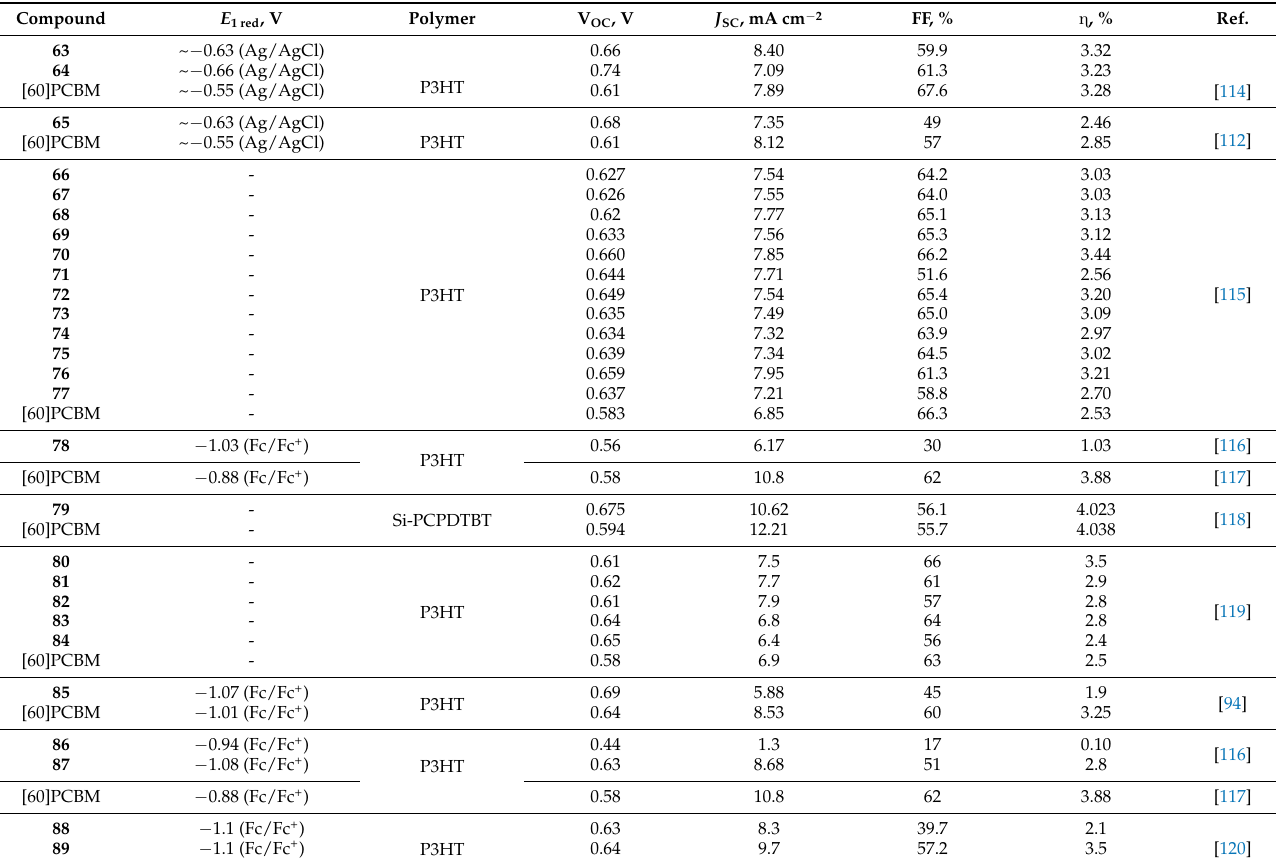
Table 2. First reduction potentials and characteristics of the solar cells based on